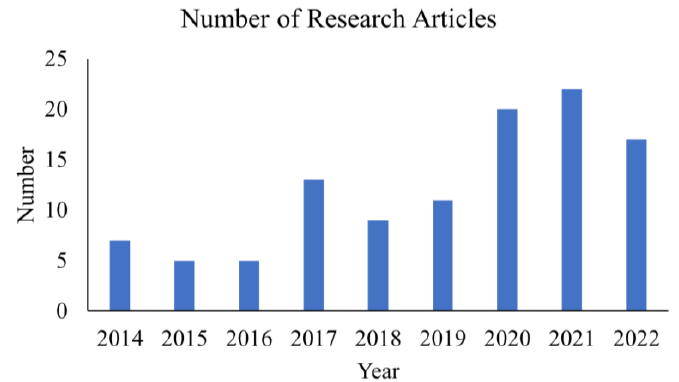
Figure 2. Graphical representation of the number of articles.